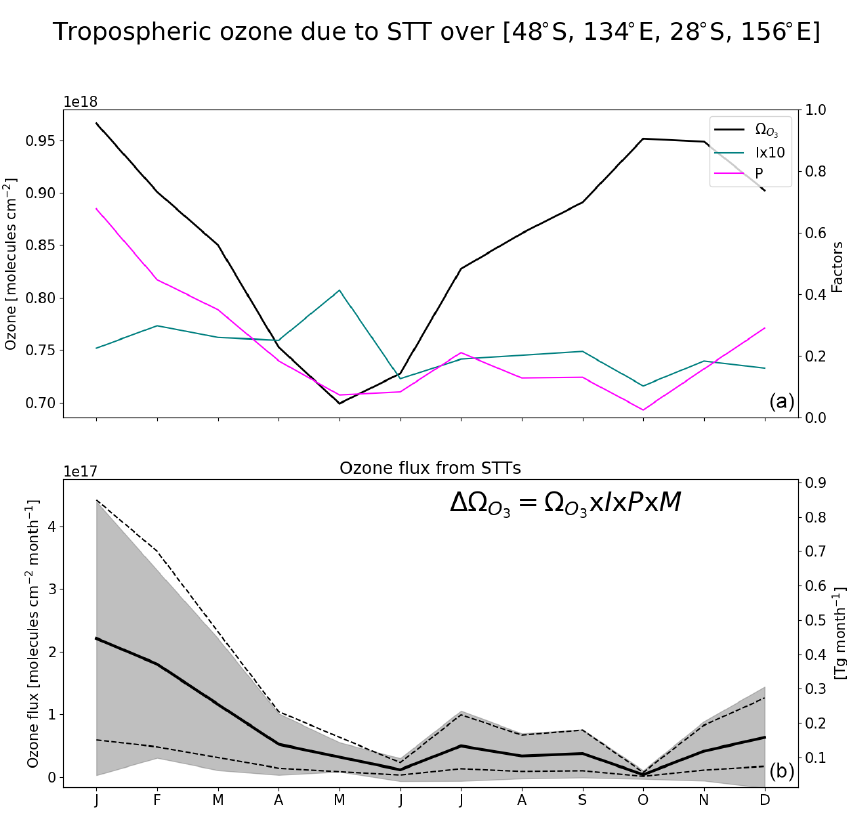
Figure 15. As described in Fig. 13, for the region containing